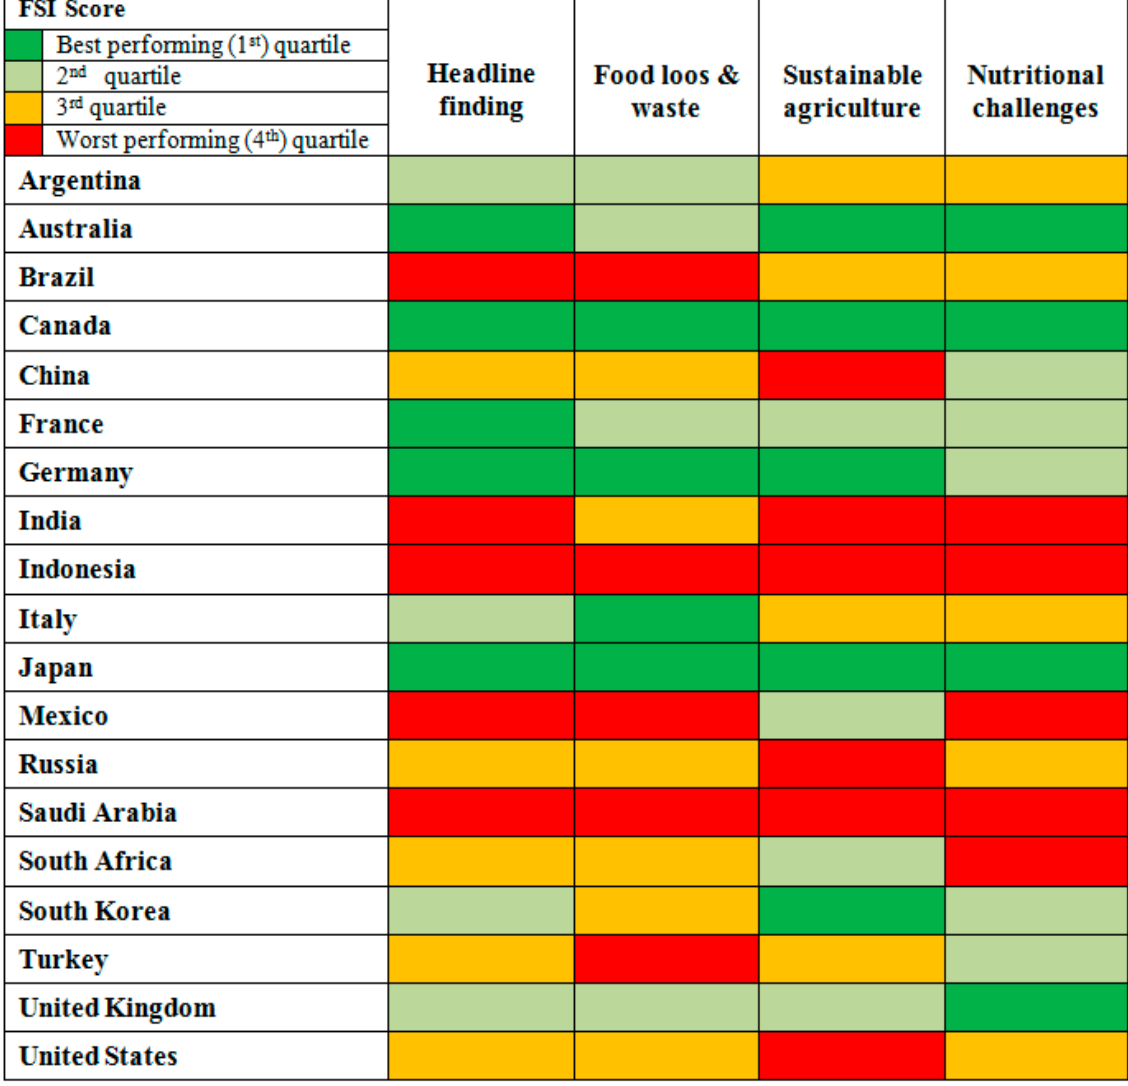
Figure 1. FSI results—G20 countries.